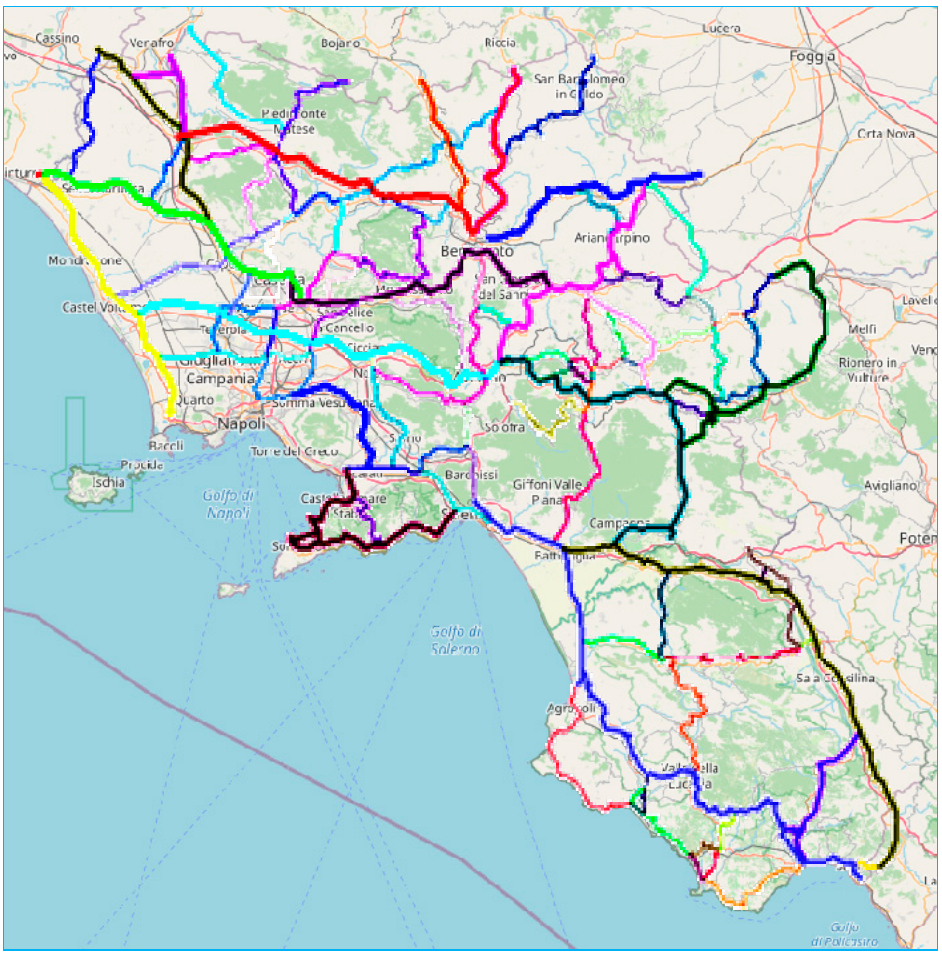
Figure A2. Identification of decision